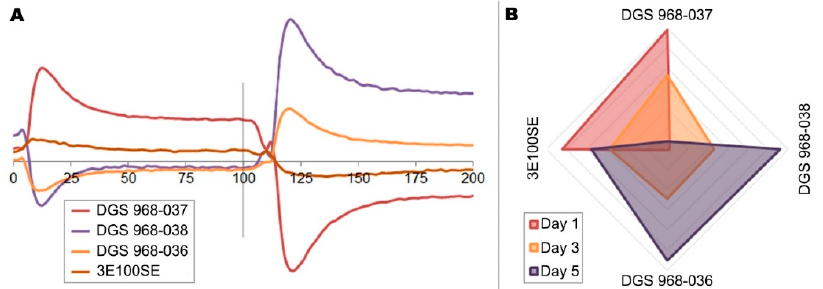
Figure 2. ( A ) Response of the four electrochemicalsensors to the change from purging to sampling mode when analyzing a sample of poultry meat after 5 days of refrigerated storage; the change of sampling modes occurs after 100 s, and the axis denotes time expressed in seconds. The spikes are the result of temporary pressure changes caused by valve operation; ( B ) radar plot of the normalized measurements of the four EC sensors when analyzing the headspace of poultry meat samples on the first, third, and fifth day of the experiment; days 2 and 4 were omitted for clarity.